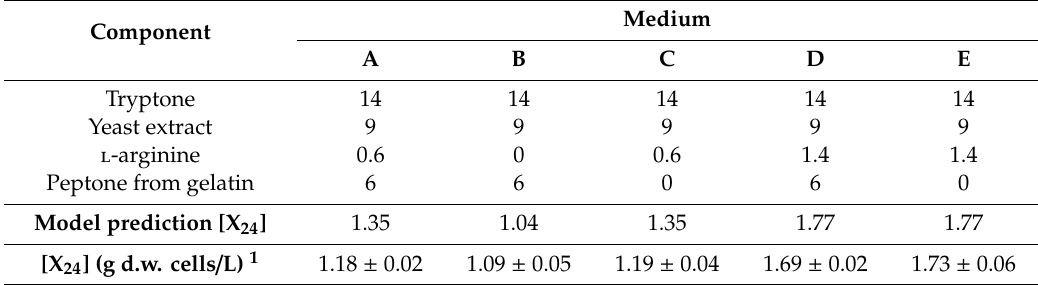
Table 5. Biomass production in syngas fermentation by Clostridium carboxidivorans after 24 h. Component